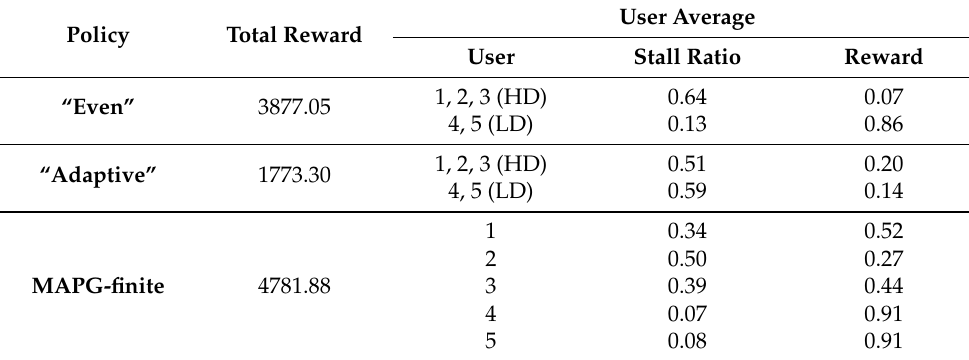
Table 3. Reward breakdown for QoE function on 1500 KB/s download